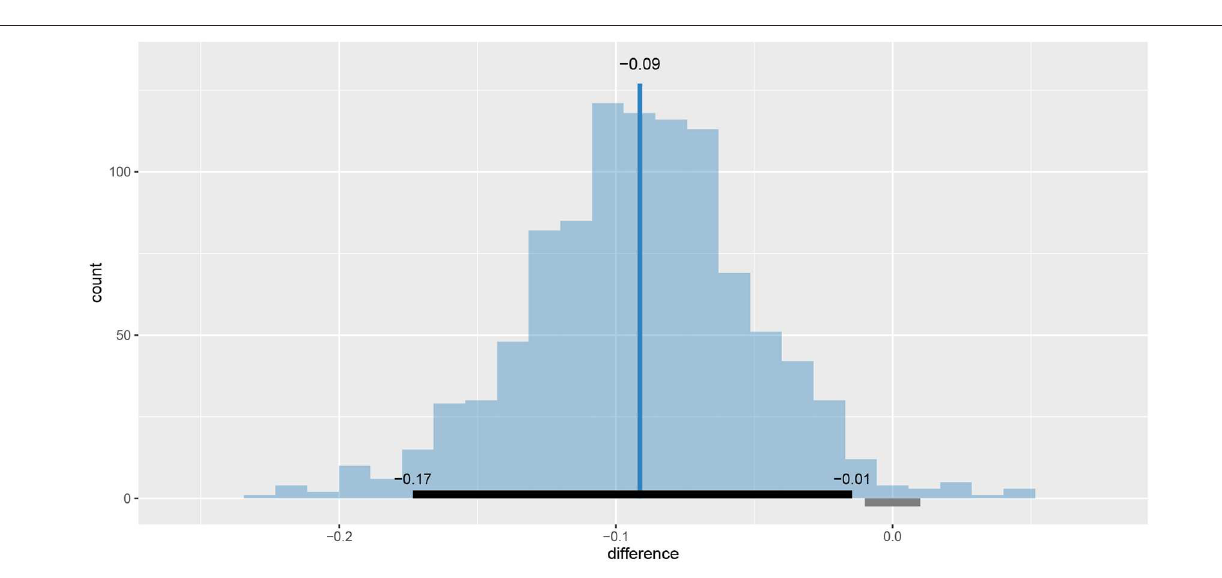
fit2= rt_ test _ fit, rope=0.01) R > plot_ means( rt_control_ fit,